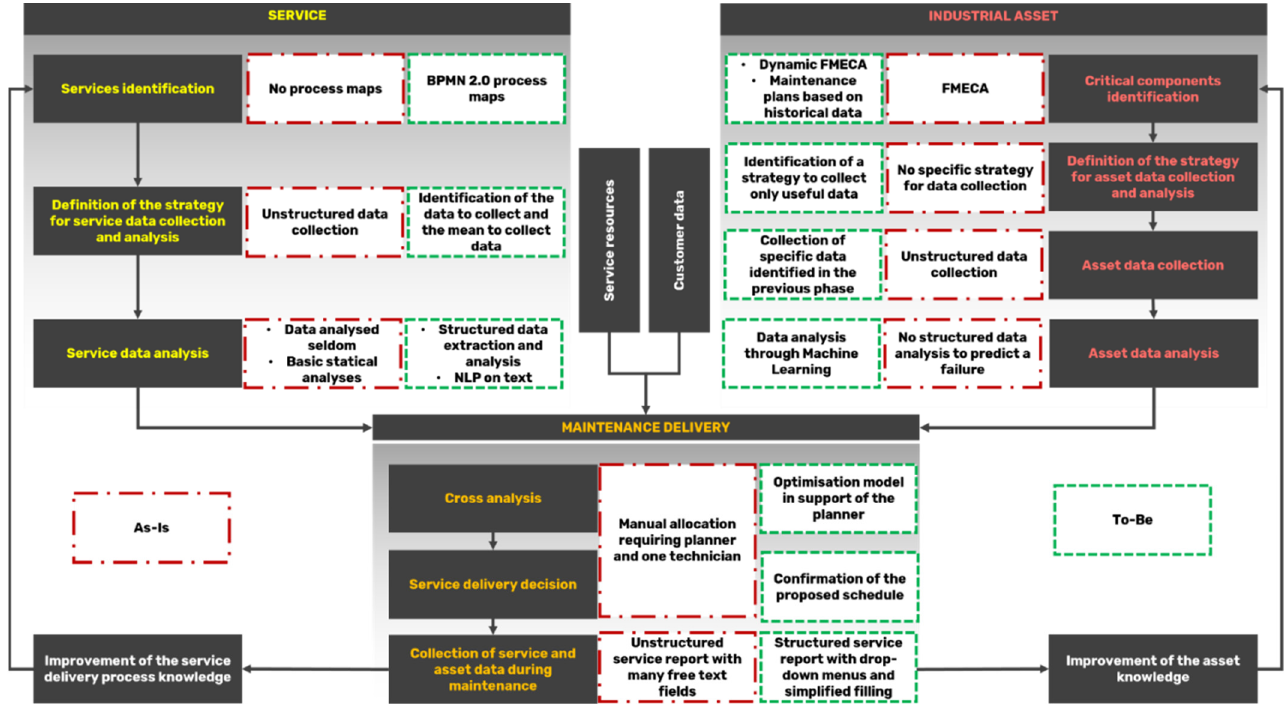
Figure 4. Company Beta pre- (red rectangles) and post- (green rectangles) D3M implementation.